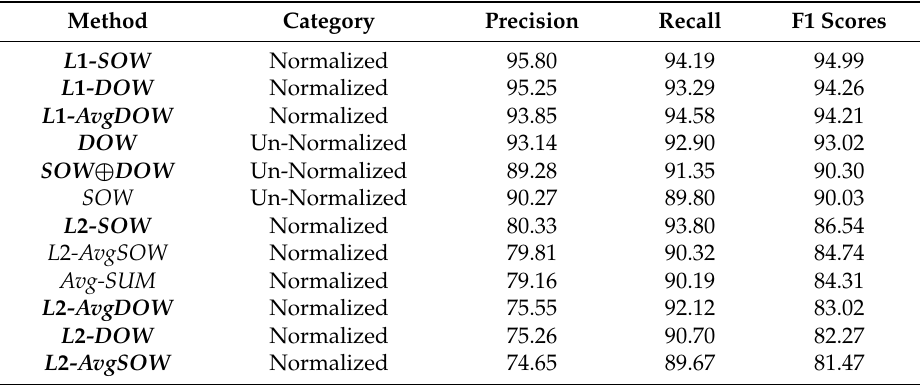
Table 10. Results summary of aspect category detection in SemEval-2015 dataset.